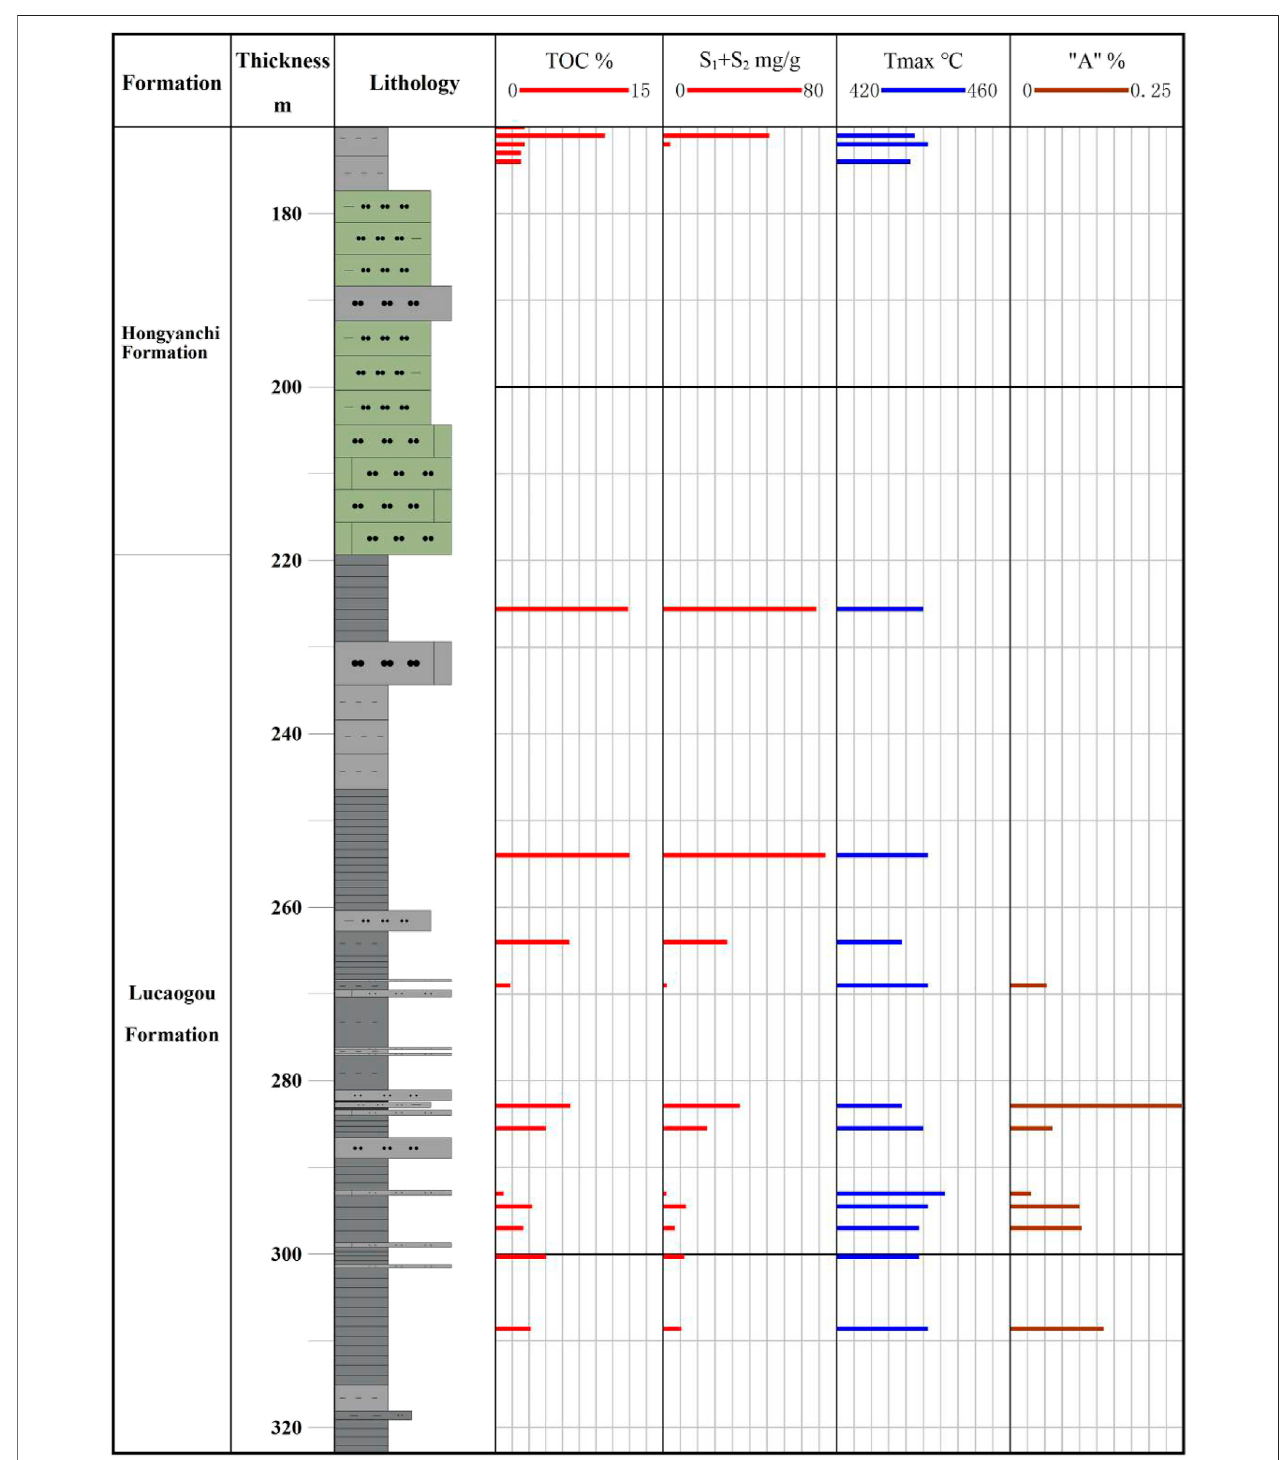
FIGURE 3 | Geochemical parameter pro fi le of P 2 l of the Dongdalongkou section.